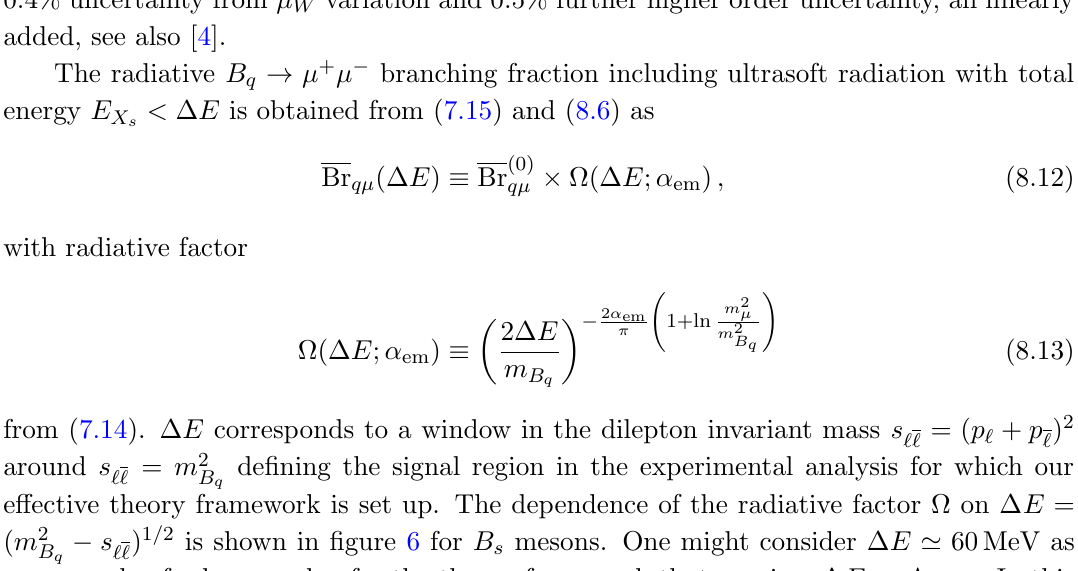
Figure 6. The radiative factor in (8.13) for B s (cid:22) + (cid:22) (cid:0) in the range (cid:1) E ! two values (cid:11) (cid:0) 1 = 134 : 28 (solid) and (cid:11) (cid:0) 1 = 136 : 0 (dashed). em em 0.4% uncertainty from (cid:22) W variation and 0.5% further higher order uncertainty, all linearly added, see also